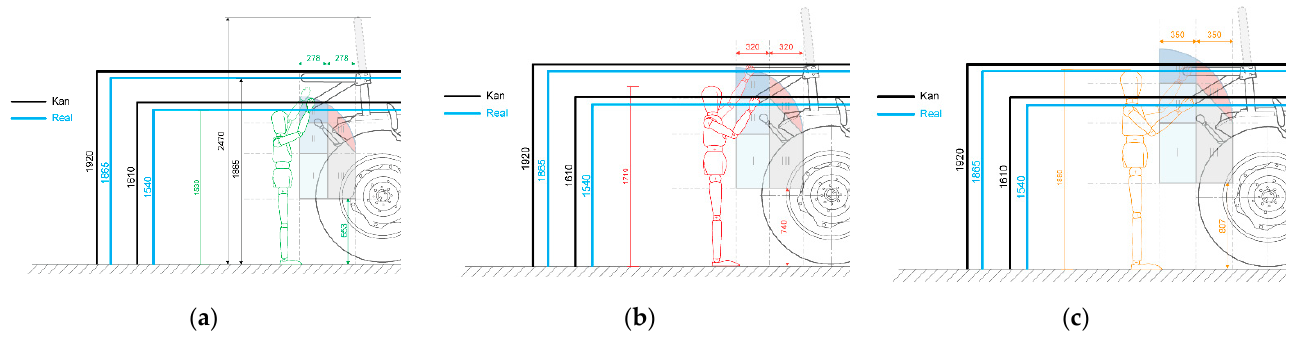
Figure 8. Distance from the ground to the manually operated part, both in the actual context and as reported in the KAN study 50 for: ( a ) the 5th percentile, ( b ) the 50th percentile, and ( c ) the 95th percentile.